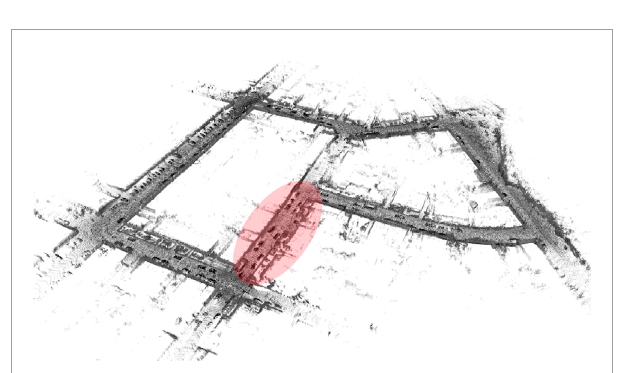
FIGURE 10 3D map obtained through the re-localization experiment. The red zone consists of frames that are not used for tracking, and for which the odometry is computed through OSM map alignment.